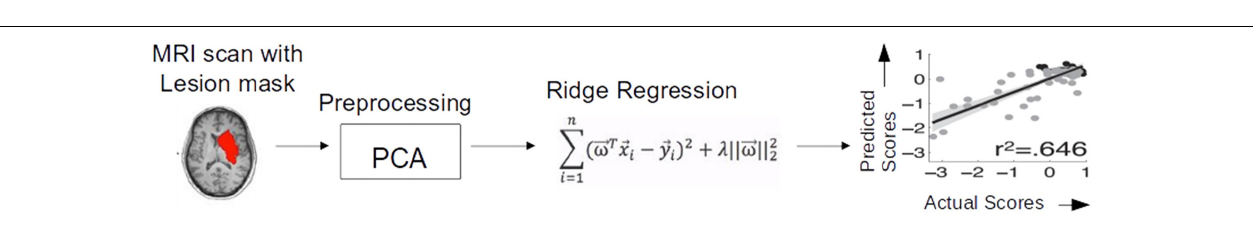
FIGURE 2 | Ridge regression method used by Siegel et al. (2016) for predicting behavioral deficits in stroke patients from MRI lesion